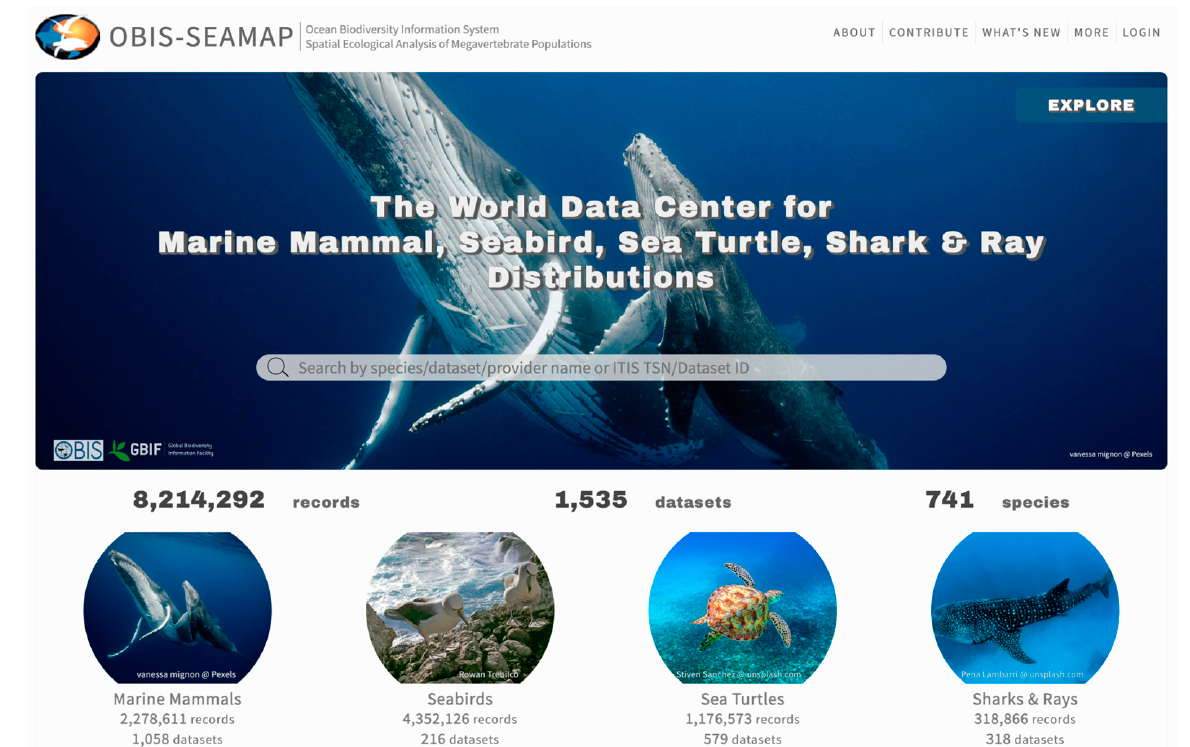
Figure 13. The Ocean Biodiversity Information System Spatial Ecological Analysis of Megaverte- brate Populations (OBIS-SEAMAP) web application, which coalesces marine mammal, sea turtle, seabird, ray, and shark sightings from contributors around the world (https://seamap.env.duke.edu/ (accessed on 23 December 2022)).